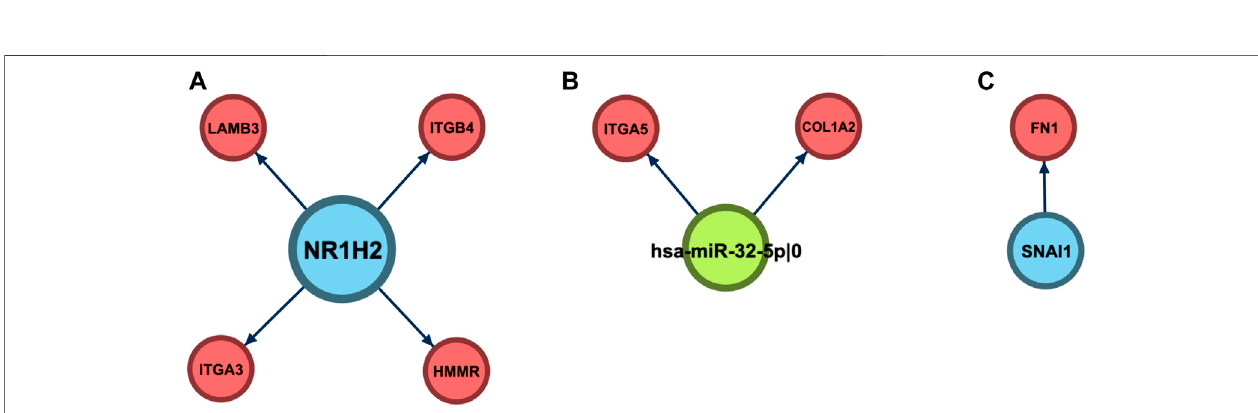
FIGURE 7 | Regulatory neighborhood of the prognostic 5 ′ -isomiR/gene triple. (A) NR1H2. (B) hsa-miR-32 – 5p|0. (C) SNAI1.